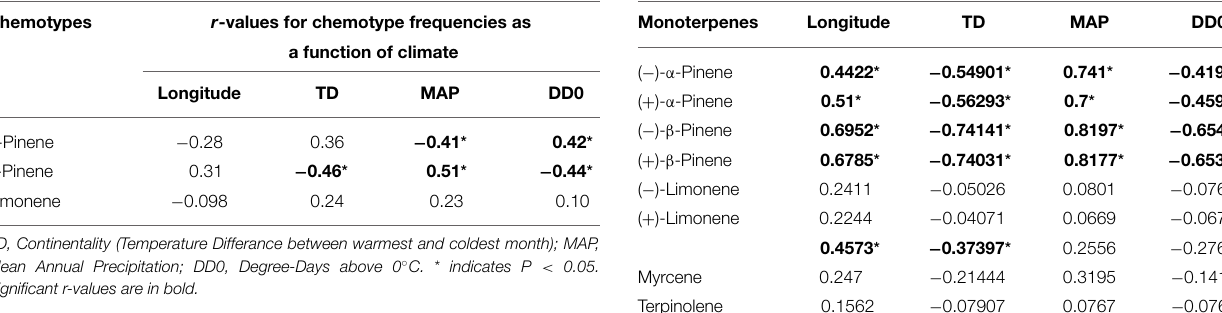
TABLE 2 | Pearson correlation coefficient values ( r ) between climatic variables and chemotype frequencies from natural stands of jack pine ( Pinus banksiana ) populations in Canada and northeastern U.S.A.